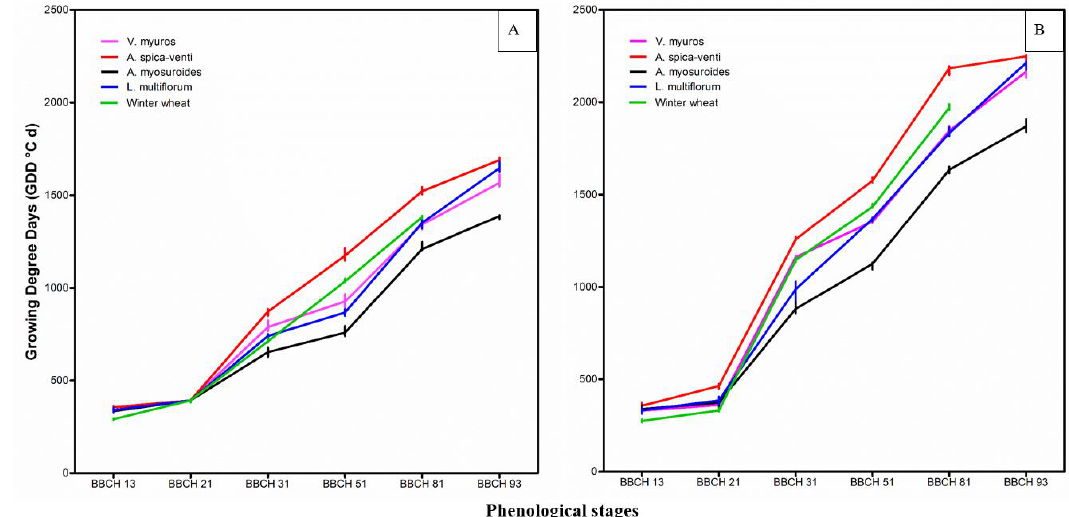
Figure 3. Thermal time (°C) for the grass weeds and winter wheat to reach various phenological stages in 2017/18 ( A ) and 2018/19 ( B ). Mean values and 95% bootstrap confidence intervals are presented in supplementary material (Table S1 (2017/18) and Table S2 (2018/19)).